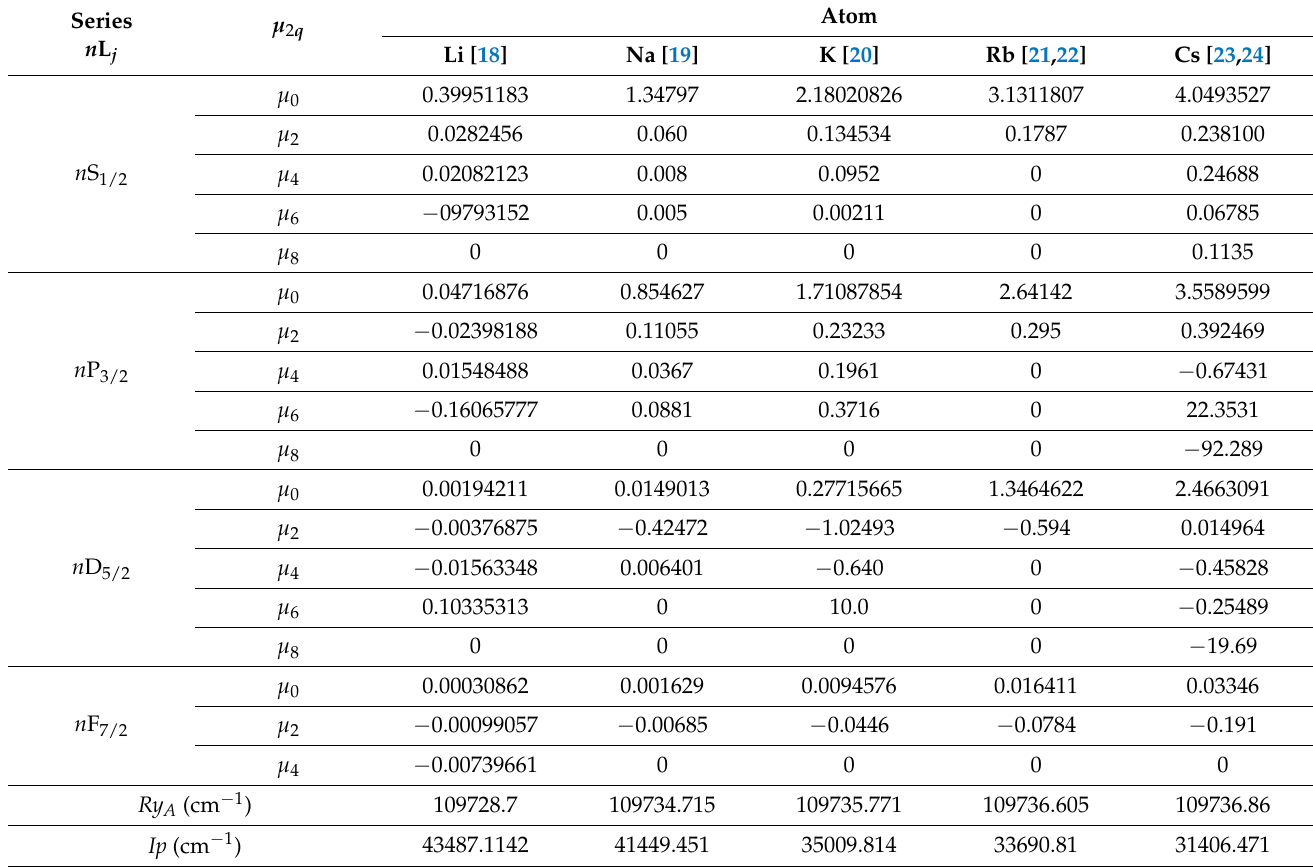
Table 1. Numerical data for constants determining the quantum defects and energies of alkali-metal atoms’ Rydberg states from Equations (4) and (5). The source references are given in